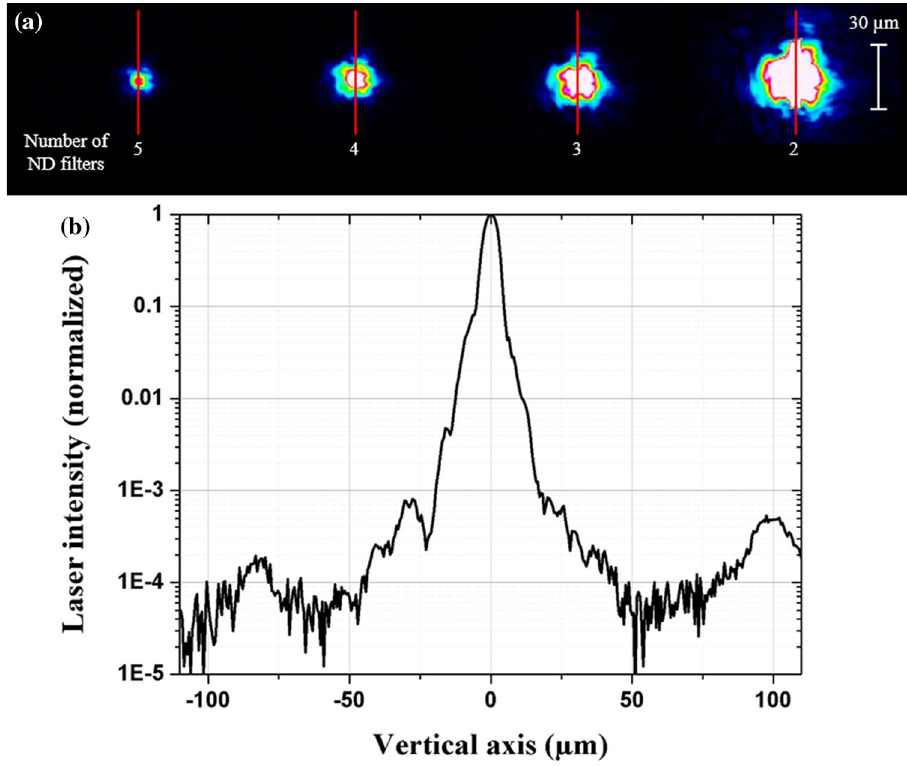
Figure 3. (a) Snapshots of the laser spatial beam distribution. Differences between each snapshot correspond to the removal of one neutral density filter. (b) Stacked vertical laser focal spot size profile coming from the red line profile on the images presented in (a) . Wings are present and their intensities are I < 5.0 × 10 16 W/cm 2 , even when the laser peak intensity is measured at I ~ 1.0 × 10 19 W/cm 2